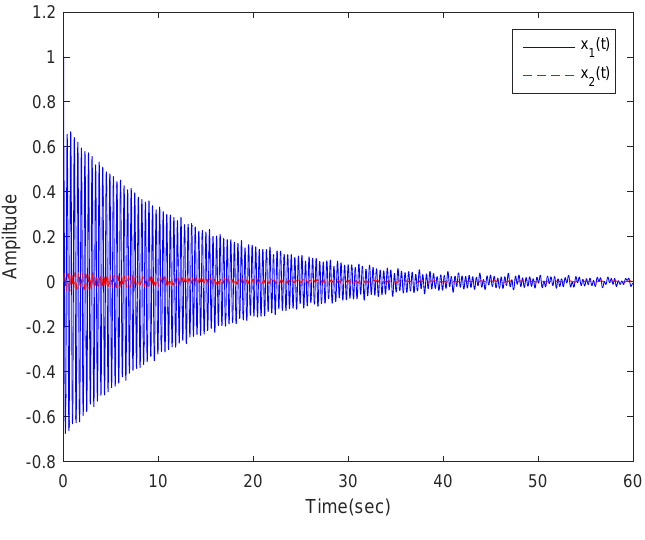
Figure 6. System states of system (50) with controller K